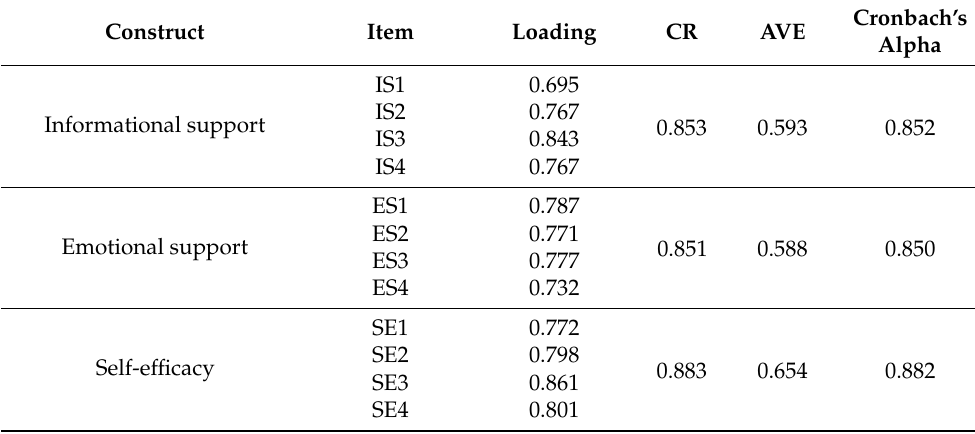
Table 2. Latent variables